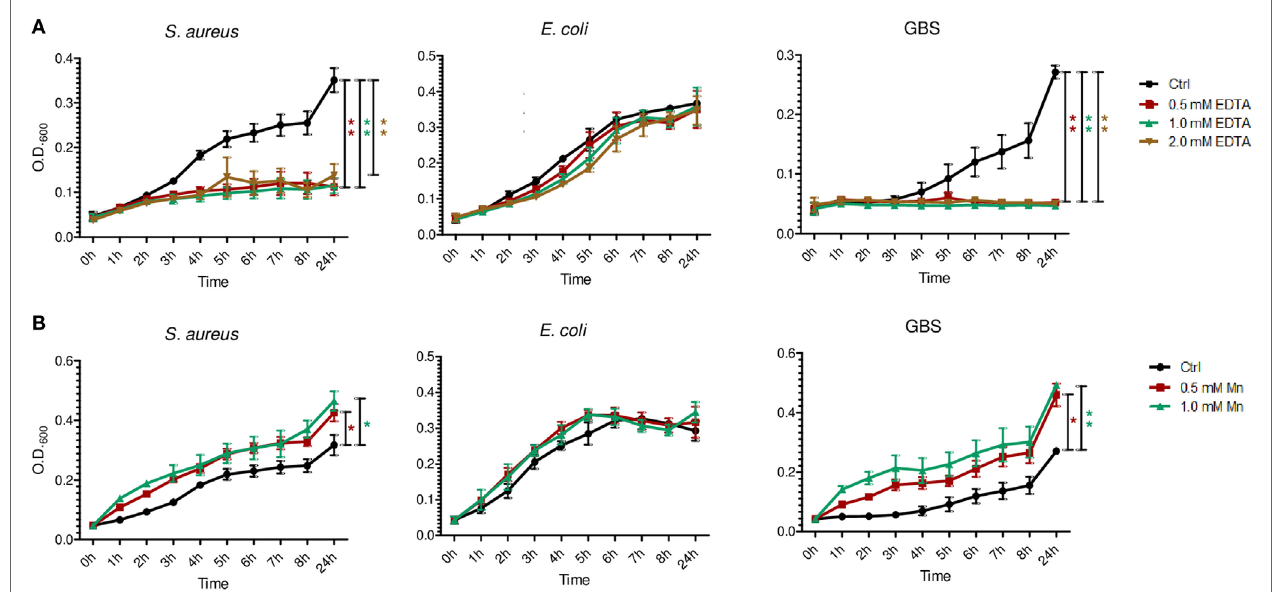
FigUre 5 | Differential susceptibility of bacterial growth to metal ion depletion. Staphylococcus aureus , Escherichia coli , and group B streptococci (GBS) were grown at indicated concentrations of EDTA (a) and manganese (B) . OD 600 values over time were plotted as mean ± SEM. * p < 0.05 and ** p < 0.001, t -test ( n =